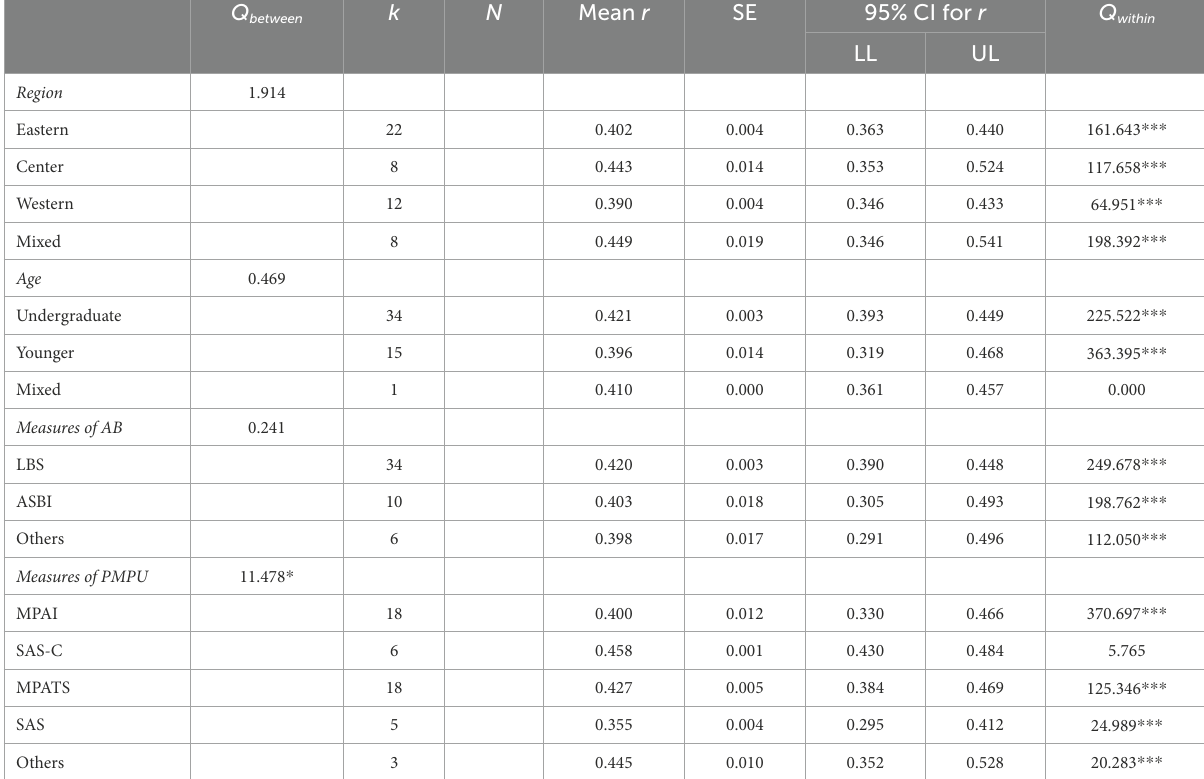
TABLE 3 Region and age and measures moderators of the association between AB and PMPU.